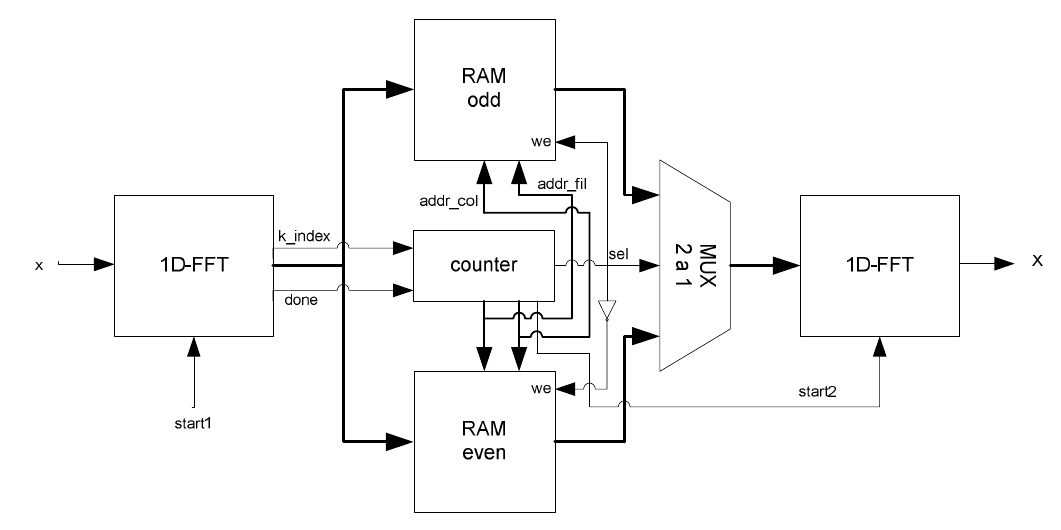
Figure 9. Block diagram of the implemented